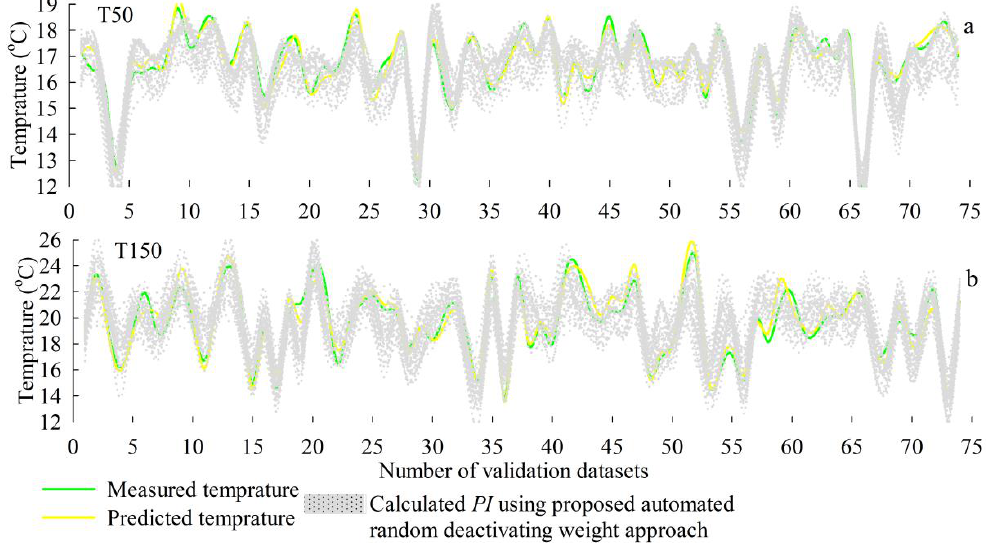
Figure 8. Analyzed uncertainty of hybrid DNSL-MFA for T50 ( a ) and T150 ( b ) using automated random deactivating weight approach according to Ref. [101].